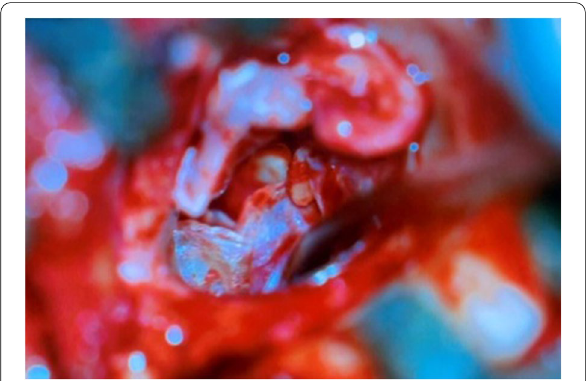
Fig. 1 Placing temporalis fascia graft medial to the handle of malleus and under the tympanic membrane